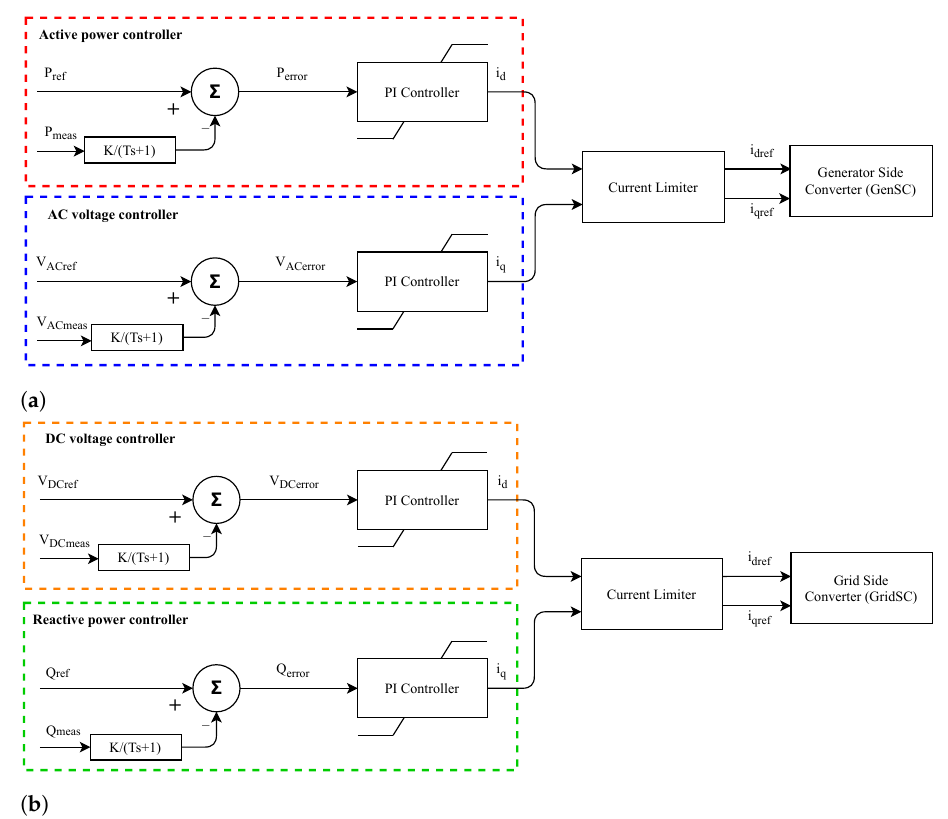
Figure 4. WT converter controllers. ( a ) WT generator side converter controller. ( b ) WT grid side converter